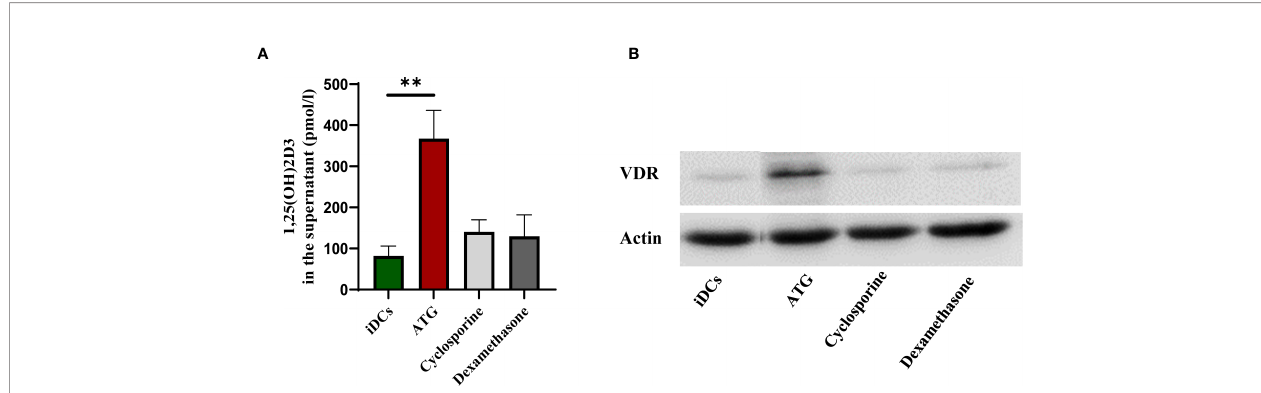
FIGURE 3 | Comparative effect of ATG, Cyclosporine and Dexamethasone on 1,25(OH)2D3 production and VDR expression. Human monocyte-derived DCs were stimulated for 24 h in the presence 100 nM 25(OH)D3 with or without ATG (100 µg/ml), Cyclosporine A (1,7 µM) and Dexamethasone (100 nM). Panel (A) After 24 h the production of 1,25(OH)2D3 was analyzed by means of chemiluminescence immunoassay. Data are means ± SEM (n = 3). Statistical analysis was performed using Kruskal-Wallis and Dunn ’ s posthoc test [**p ≤ 0.01, tested versus immature DC (control)]. In (B) , VDR expression was analysed by western blot. A representative donor is